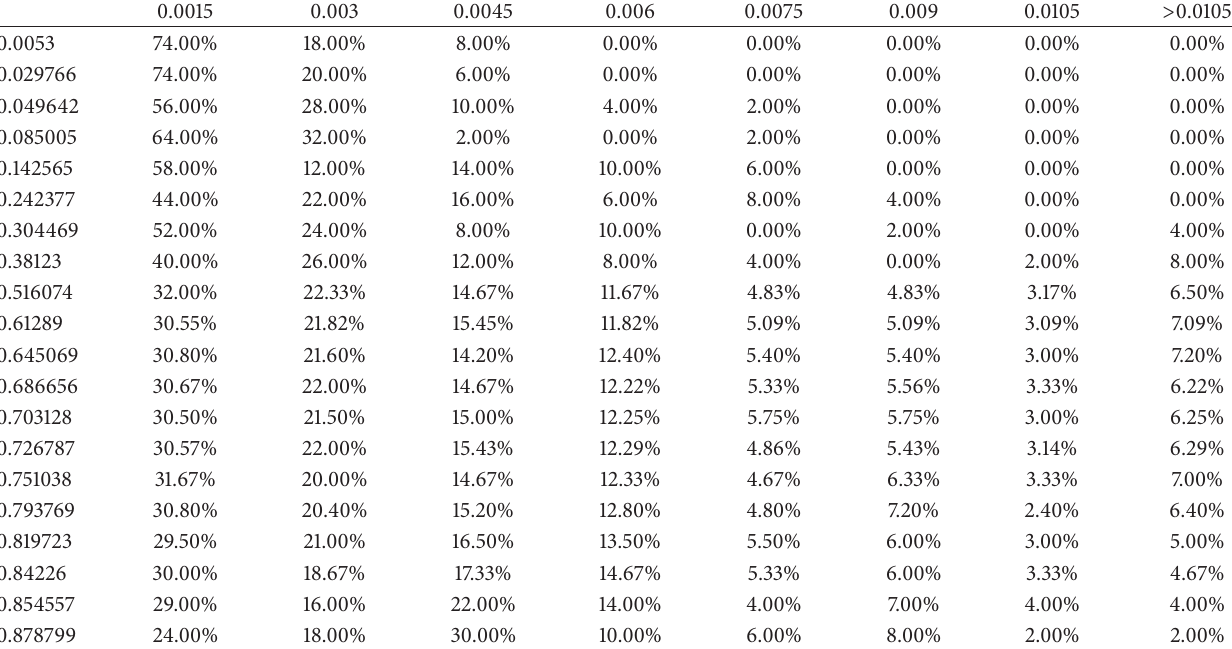
Table 2: Absolute yields under VPIN conditions when the proportion of informed investors is